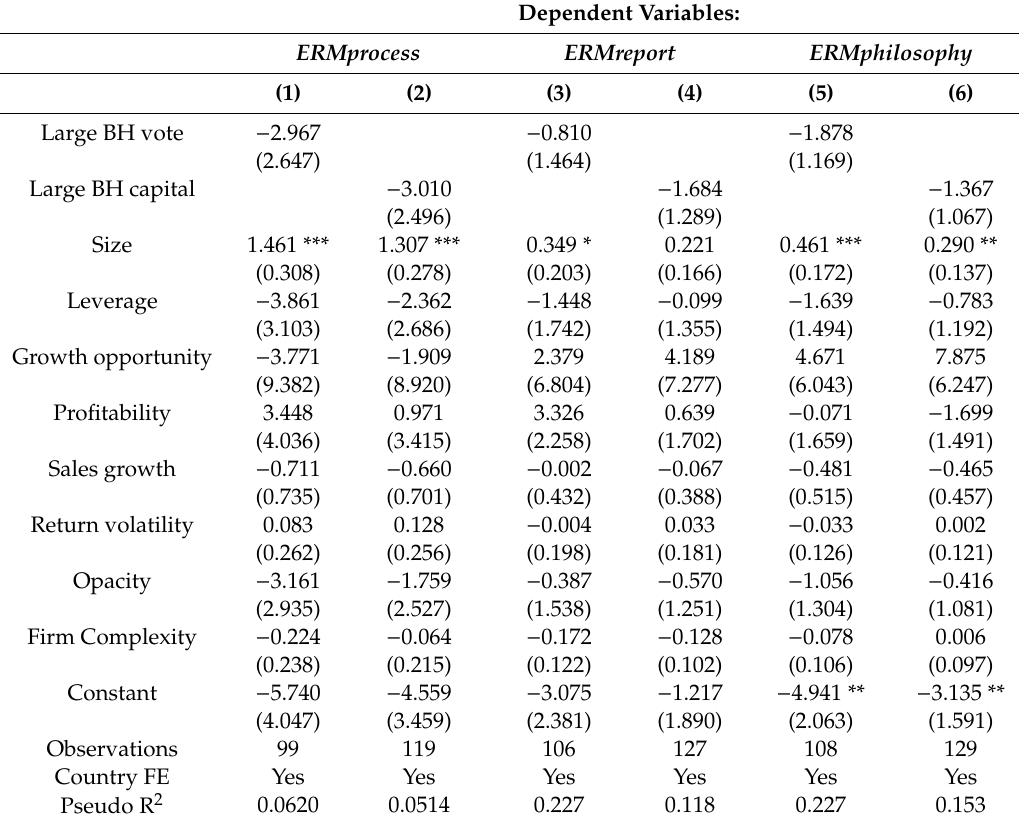
Table 3. The Largest Owner’s Power and Enterprise Risk Management